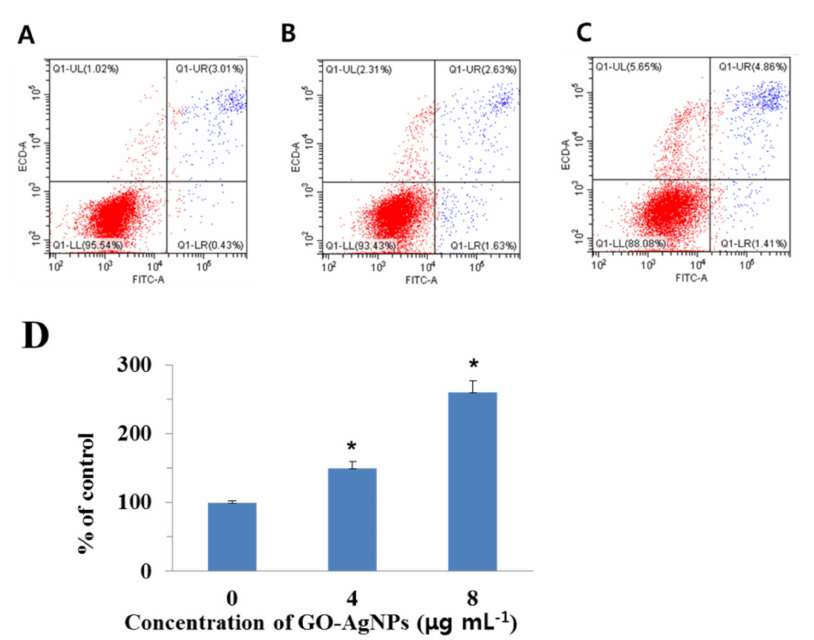
Figure 5. Evaluation of GO-AgNP-induced apoptotic cell death with the annexin V–FITC/propidium iodide (PI) staining assay. Caprine fetal fibroblast cells (CFFCs) were treated with 0 ( A ), 4 ( B ), and 8 µ g/mL ( C ) of GO-AgNPs for 24 h, and FACS was carried out for detection of fractions of early apoptotic, late apoptotic, and necrotic CFFCs. The corresponding linear diagram of flow cytometry is shown in ( D ). Values are presented as the mean ± SD of five independent experiments (* p <